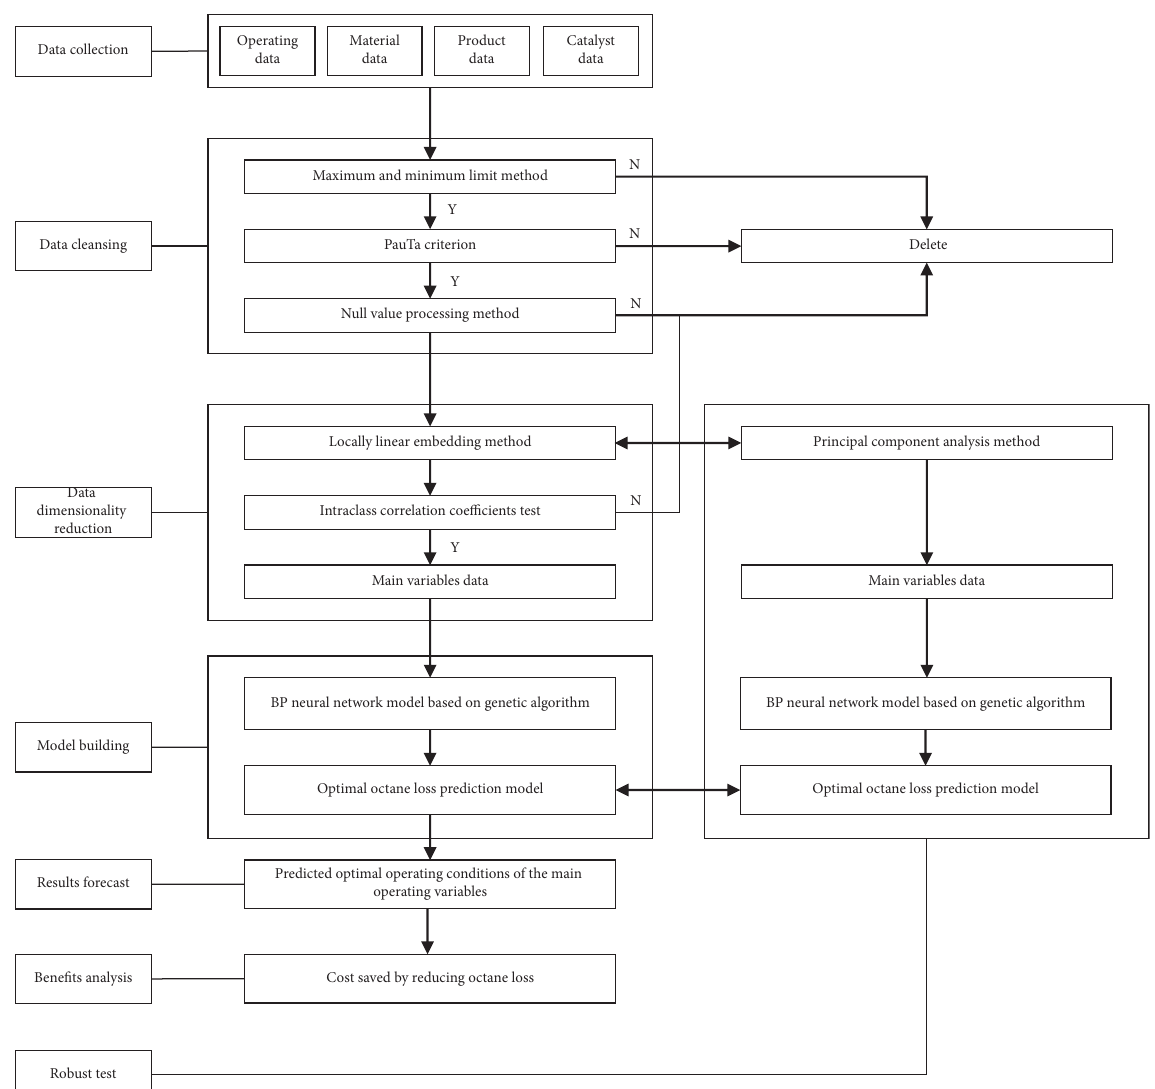
Figure 1: The flow chart of optimization modeling on gasoline octane